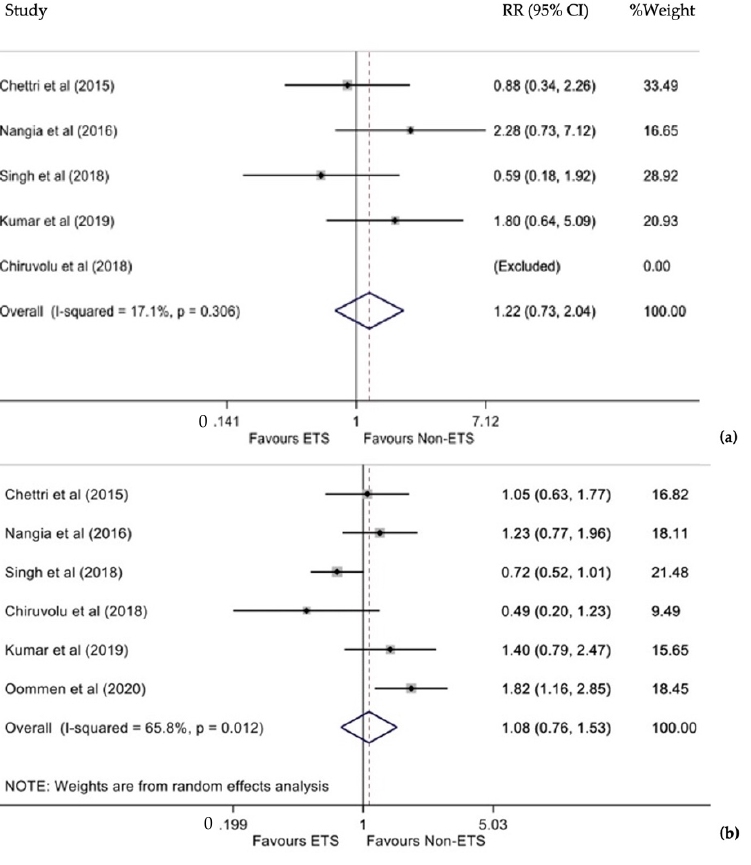
Figure 2. ( a ) Forest plot of relative risk (RR) for death between endotracheal suction (ETS) and non-endotracheal suction (non-ETS). ( b ) Forest plot of RR for MAS between ETS and non-ETS.